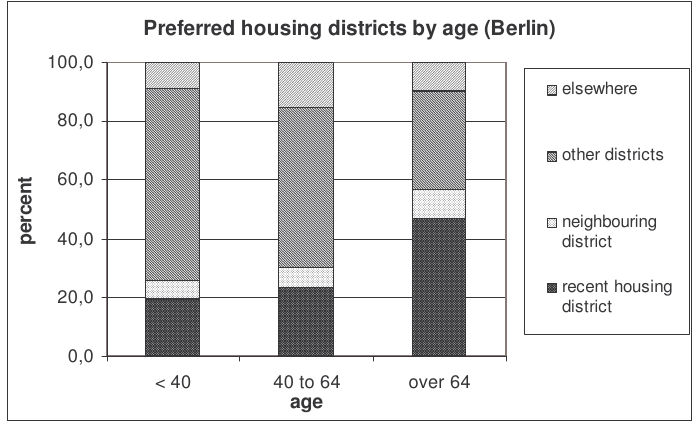
Figure 1. Preferred housing district by age in percent Source: Scheiner and Holz-Rau (2002) (survey in Berlin